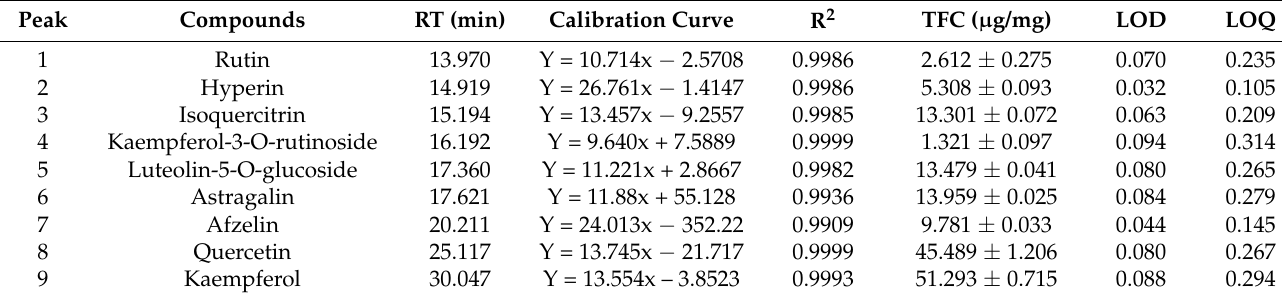
Table 3. Components and contents of flavonoids from